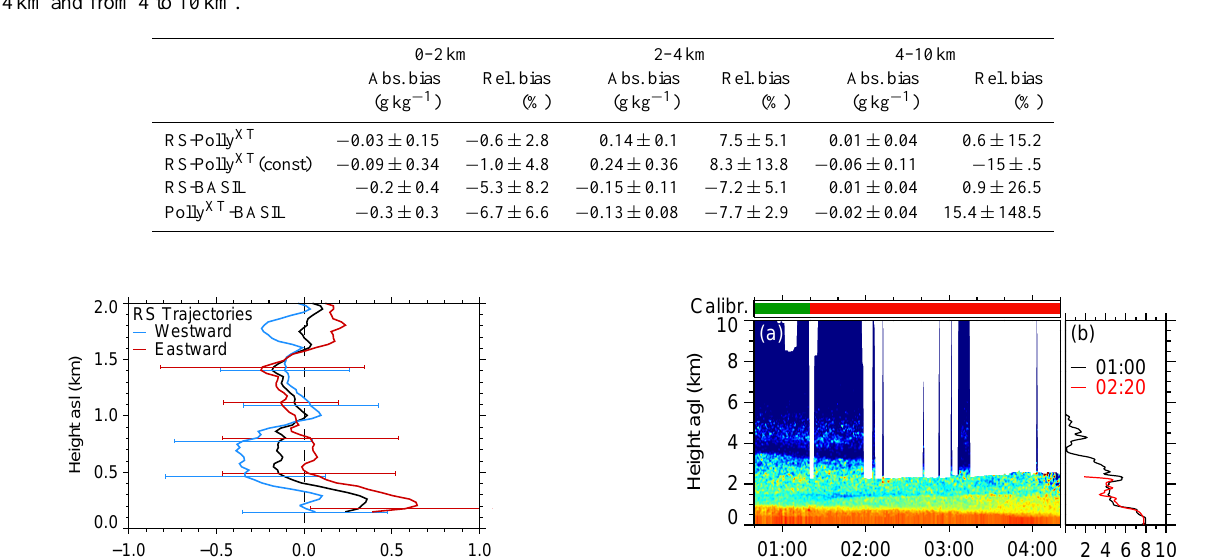
Table 2. Absolute and relative bias for water vapour mixing ratio (mean ± SD). Values are represented for the layers from 0 to 2km, from 2 to 4km and from 4 to 10km.